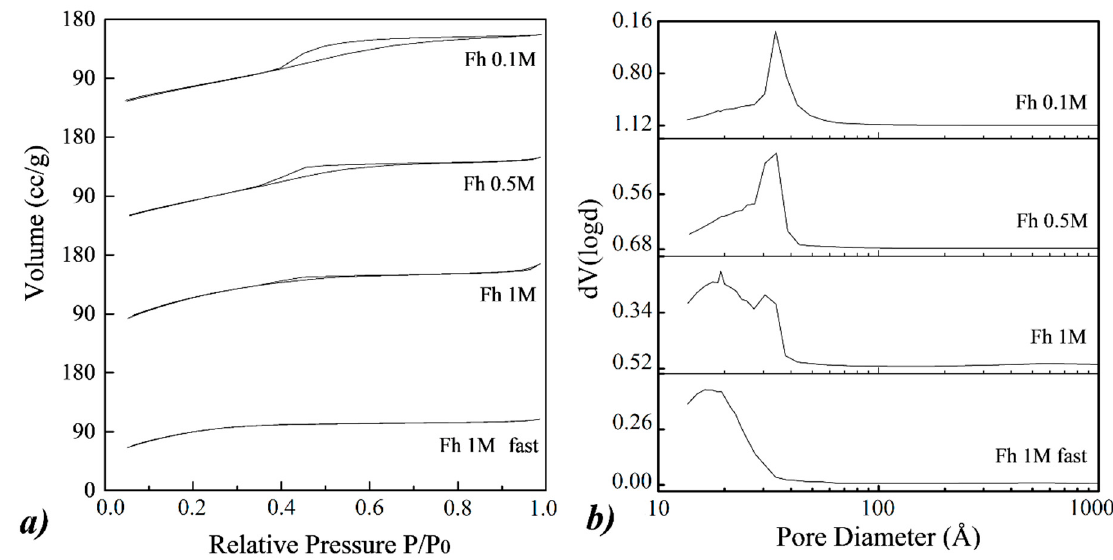
Figure 4. ( a ) N 2 adsorption/desorption isotherms and ( b) Barett–Joyner–Halenda (BJH) distributions for the desorption branch of the isotherms of different ferrihydrite samples. From top to bottom: Fh 0.1M , Fh 0.5M , Fh 1M , and Fh 1Mfast .